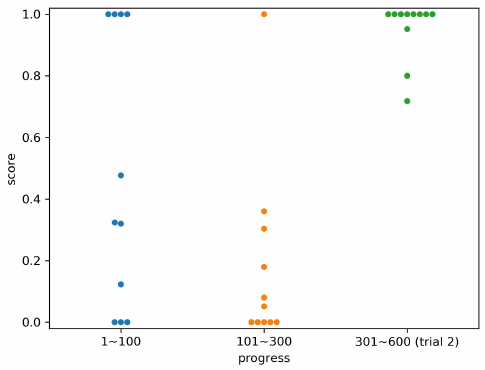
Figure 12. Scores of Subject 2 by time period.